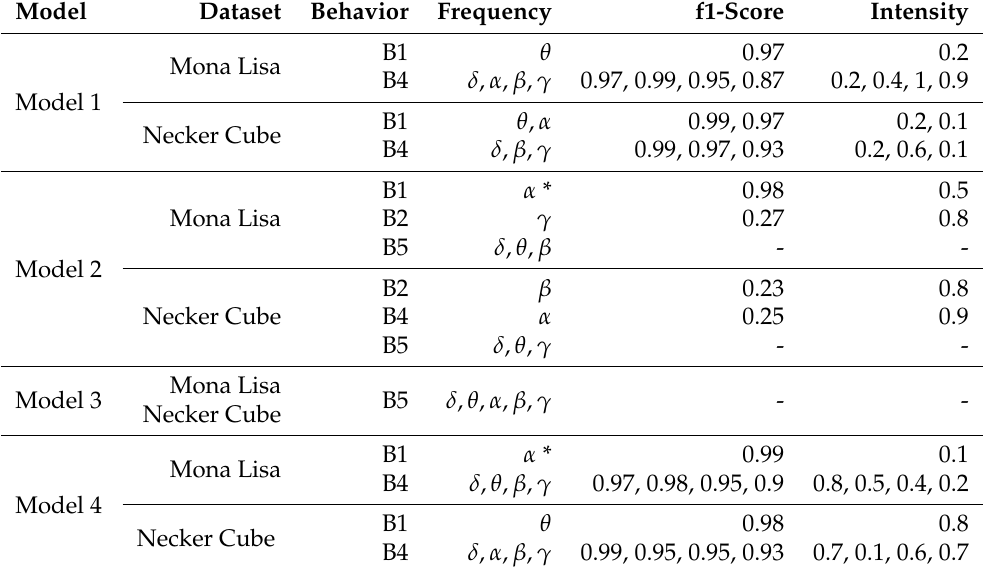
Table 7. The results of using the models with rmsprop optimizer for intensity classification.